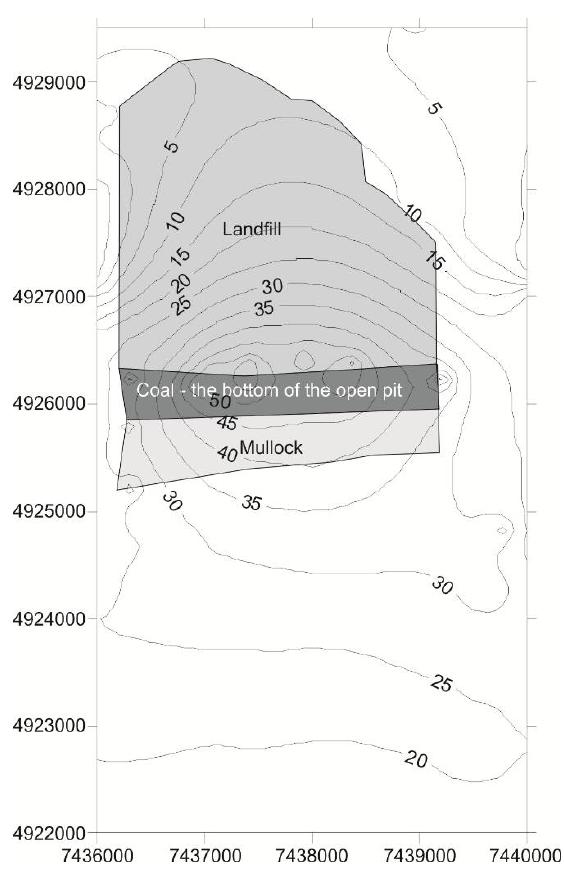
Figure 16. Groundwater mound two months after the flood (July 2014).